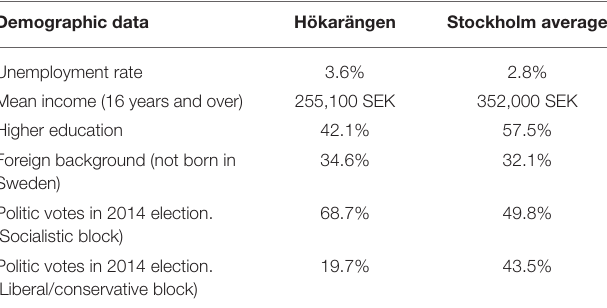
TABLE 1 | Demographic data for Hökarängen compared to the Stockholm (municipality) average, the data was received from Statistik om Stockholm (n.d), and collected in year